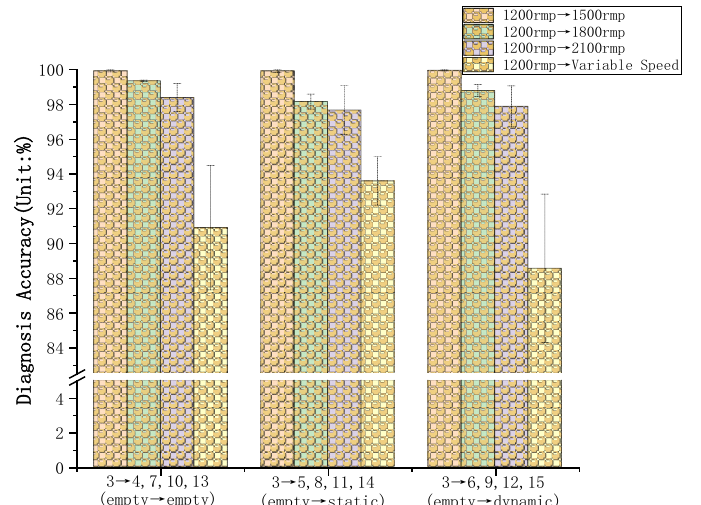
Figure 11. The results between condition No. 3 and the other 12 conditions divided into three groups based on the same load conditions.